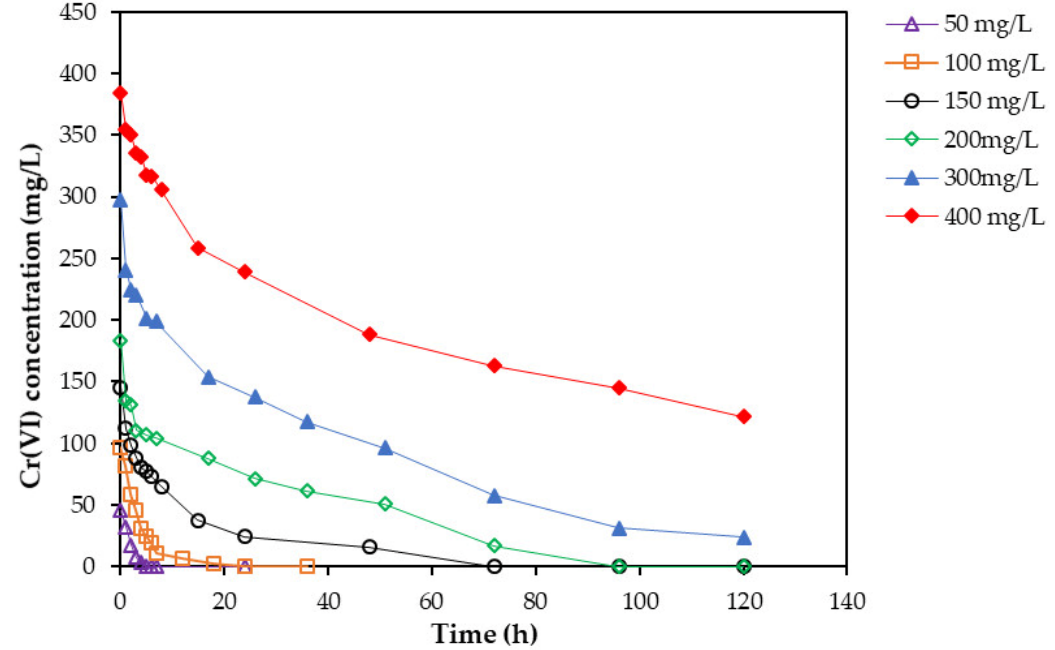
Figure 2. Effect of initial Cr(VI) concentration on Cr(VI) reduction using indigenous consortia bacteria.